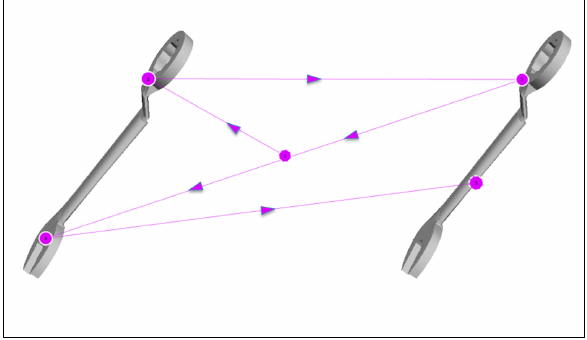
Figure 4: Gaze pattern 2 – Elaborate Gaze Pattern 3: In the third gaze pattern (Figure 5) all features are compared with each other. In contrast to the second gaze pattern, the view does not shift from one side to the other but from the second stimulus detail to the opposite direction. The scan path forms a square, which is the reason for calling this gaze pattern ‘Square’.